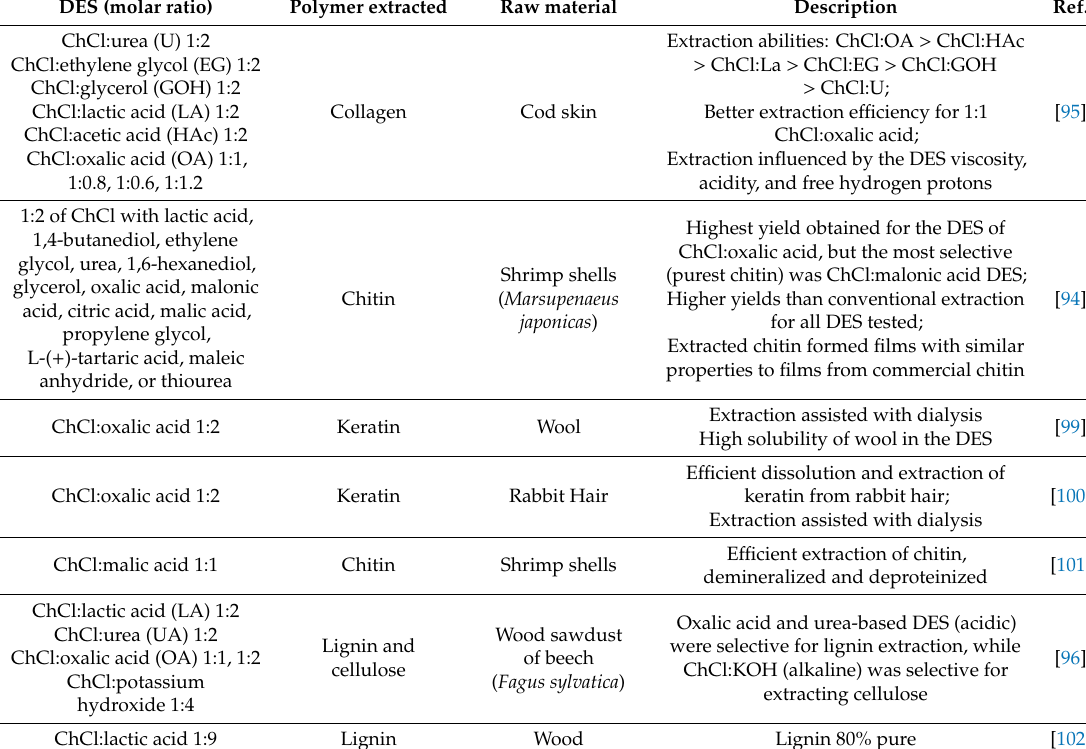
Table 3. Summary of some reported studies on polymer extraction with DES, from 2017 to 2019. DES (molar ratio) Polymer extracted Raw material Description